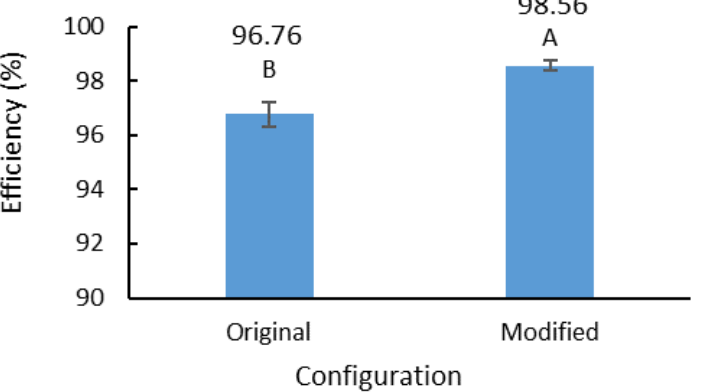
Figure 9. Material-conveying efficiency of different feeder house configurations. Means followed by different letters are significantly different according to Duncan’s multiple range test at the significance level of 0.05, and error bars are standard deviations.